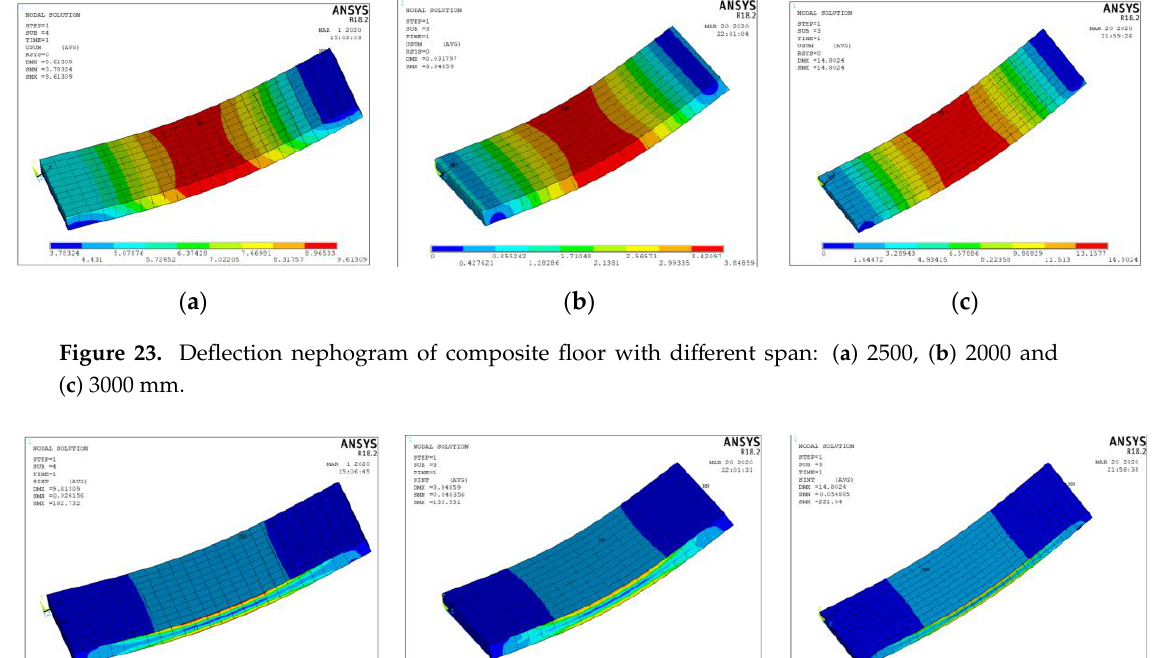
Figure 22. Stress nephogram of composite floor with different cavity size: ( a ) 100, ( b ) 125 and ( c ) 250 mm.